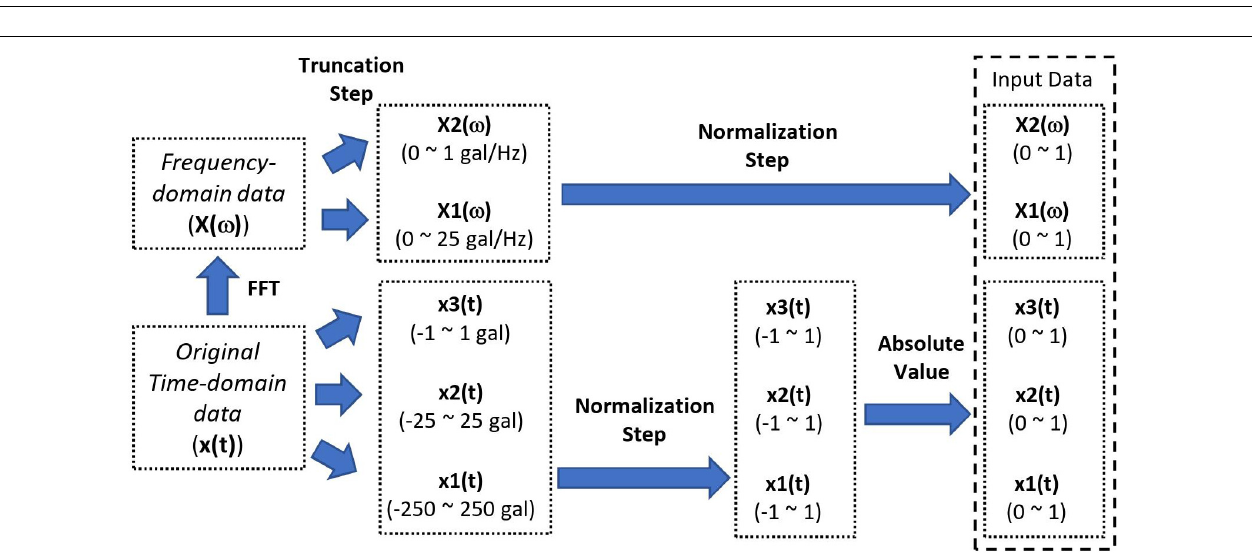
FIGURE 5 | The box plots of the RMSLE of the Cases TH6+F3 to TH6+F123.